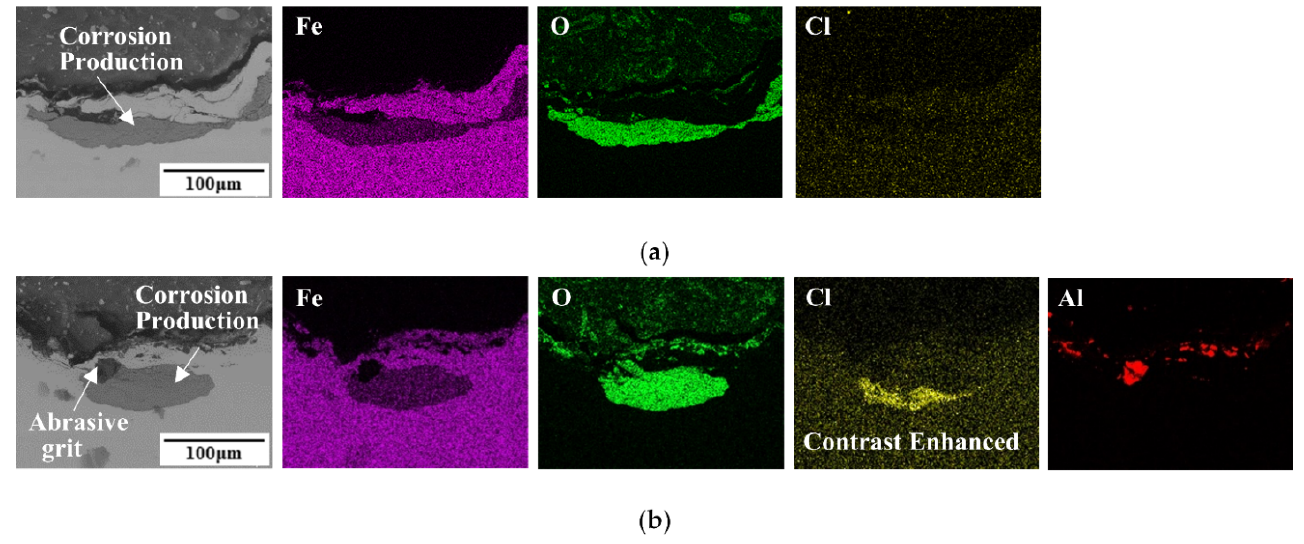
Figure 15. SEM-EDX images on the cross-section of the blasted specimens: ( a ) CST, ( b ) CAL.